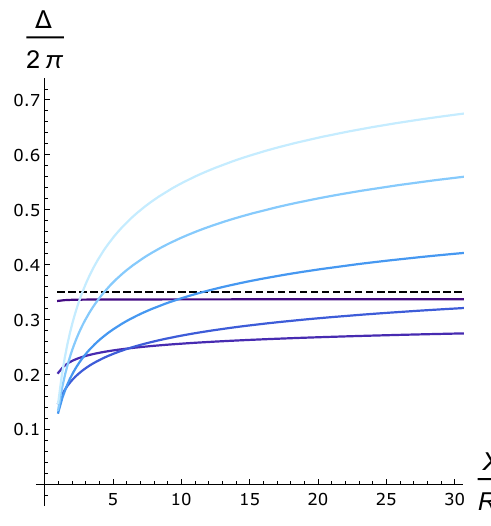
(a) Radial embedding diagram ( Y = 0): rotation (b) De(cid:12)cit angle as \seen" by a local bulk ob- leads to a widening of the cone close to the brane. server. Further away curvature decreases and a Far away a (cid:13)at conical pro(cid:12)le is approached. constant de(cid:12)cit angle is approached. Figure 4 . Deformed cones for sub-critical tension, (cid:22) (cid:21) = 0 : 35, and (cid:22) ! 2 2 f 0 : 01 ; 0 : 15 ; 0 : 3 ; 0 : 45 ; 0 : 6 ; 0 : 7 g [from dark to light, corresponding to the dots in the green (light) region of (cid:12)gure 3(a)]. The dashed curve represents the static case ((cid:22) ! = 0). The brane \sits" at X =